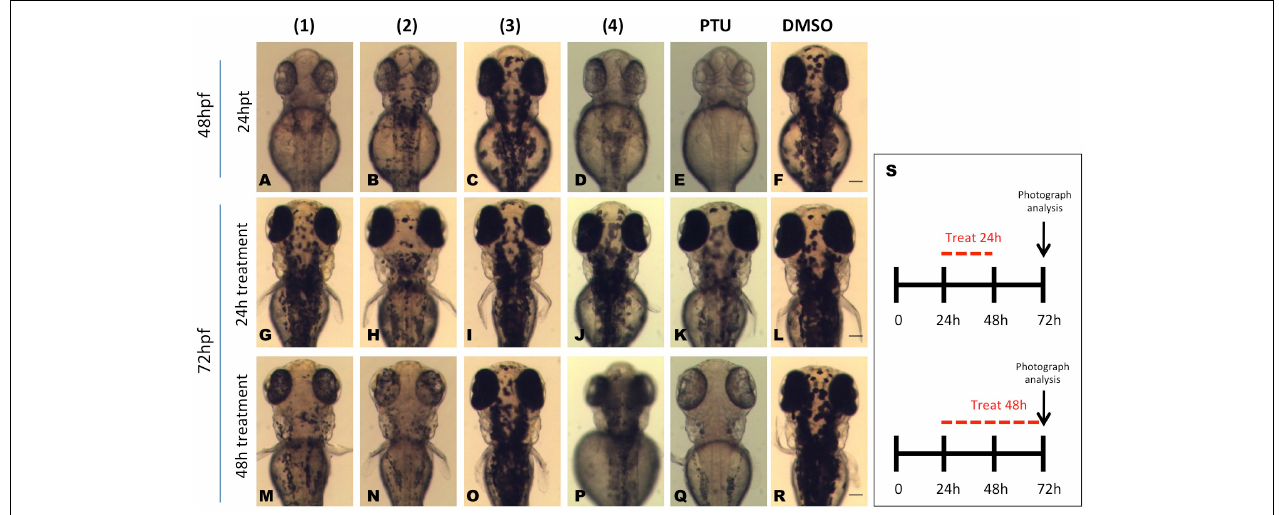
FIGURE 5 | Isolated compounds from the dibenzofuran family repress reversibly in vivo pigmentation in zebrafish. Embryos were pretreated at 24 hpf with 0.01 mg/mL test compounds for 24 h. At 48 hpf pigmentation levels were recorded (A–F) and the embryos were divided into two groups. One group was washed and bathed immediately in fresh medium, whereas the other group was incubated with dibenzofuran compounds for further 24 h. At 72 hpf, the effect on melanogenesis was assessed using a stereomicroscope for both the compound treatment stopped group (G–L) and the embryos that were continuously treated with the dibenzofuran compounds for 48 h (M–R) . PTU (E,K,Q) and DMSO (F,L,R) were used as positive and negative controls, respectively. (S) A schematic representation for the schedule of pigmentation rescue study. Scale bar: 100 µ